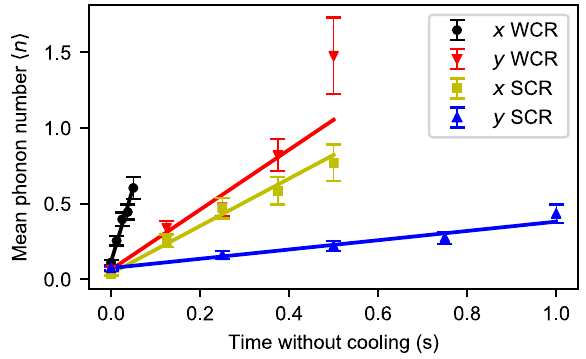
FIG. 9. Anomalous heating of the four radial motional modes of the Coulomb crystal: WCR x (black circles), SCR x (red inverted triangles), SCR y (gold squares), and WCR y (blue triangles). The fitted linear heating rate (solid lines) is also shown, with the details presented in Table III.